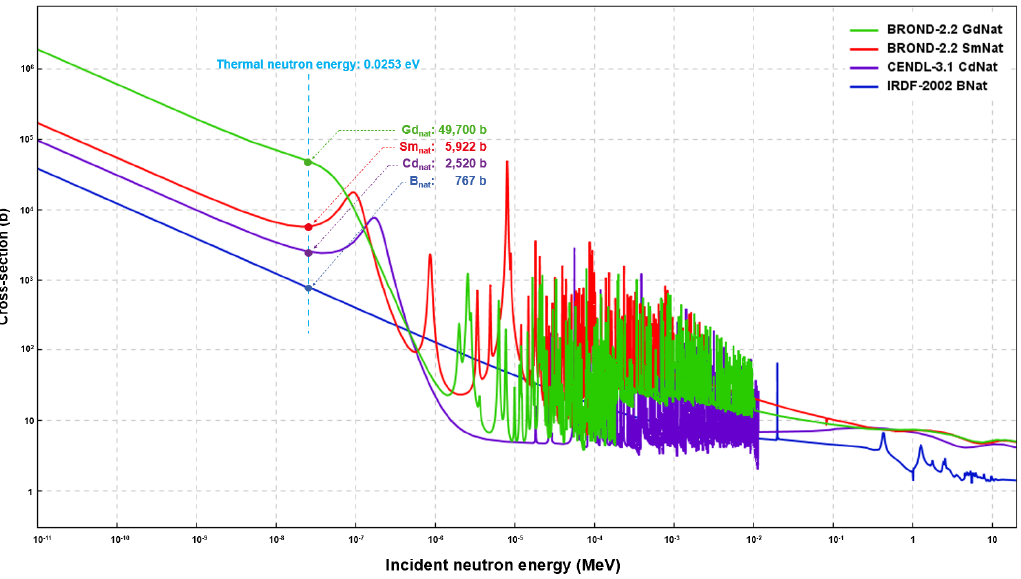
Figure 1. The neutron absorption cross-sections of Gd, B, Cd and